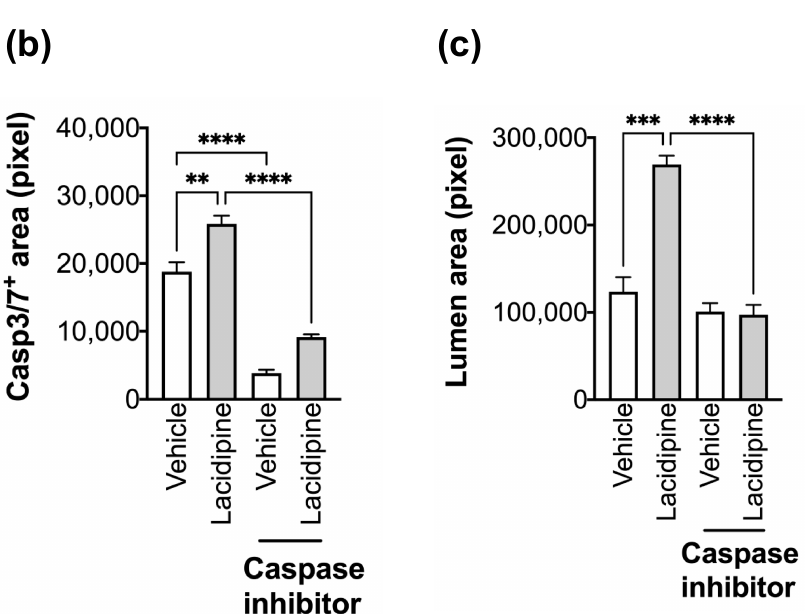
Figure 4. Effect of Lacidipine on the lumen formation is mediated by endothelial cell apoptosis. ( a ) Cell apoptosis was detected by assessing the caspase 3/7 activity (CellEvent™ Caspase-3/7 Green Detection Reagent, Invitrogen) in the presence of Lacipidine (5 μ M) or vehicle (DMSO). The caspase inhibitor was Z-VAD-FMK (100 μ M). Cells were fixed after labelling the active caspase 3/7 (green), nuclei were counterstained with DAPI (blue), and the cell body was stained with Cell Mask deep red (red). Scale bar = 50 μ m. Caspase 3/7 positive area ( b ) and lumen area ( c ) were quantified in nine fields for each well ( n = 4 per condition), data are expressed as mean ± S.E.M, one-way ANOVA followed by Bonferroni’s post hoc test, ** p < 0.01, *** p < 0.001, **** p < 0.0001.